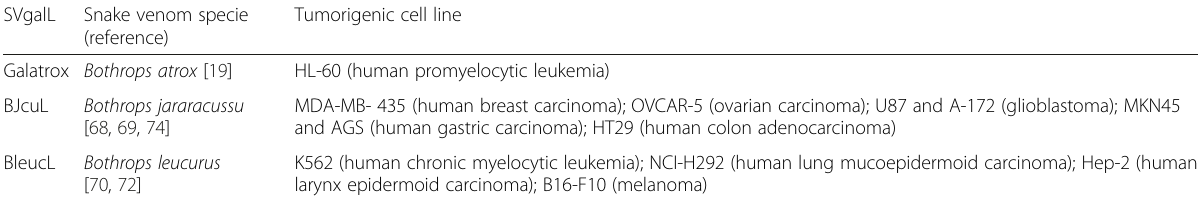
Tumorigenic cell line